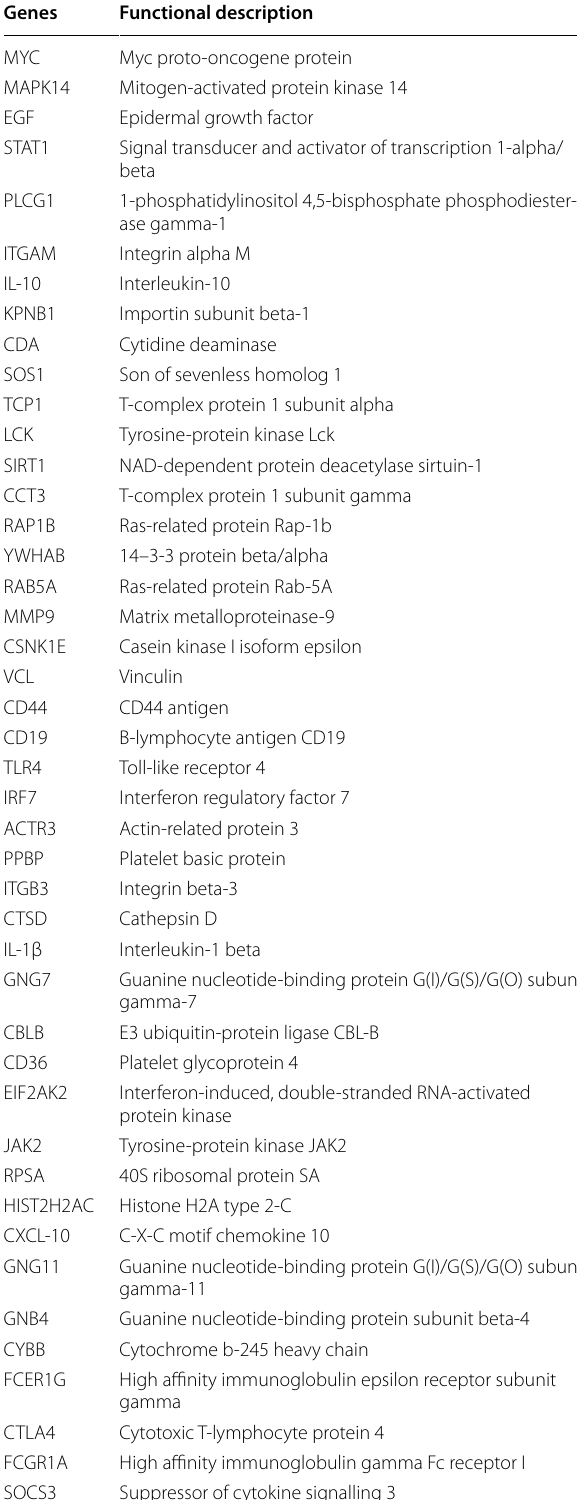
Table 4 List of DEGs (nodes) with large degree and high BC and their CC values